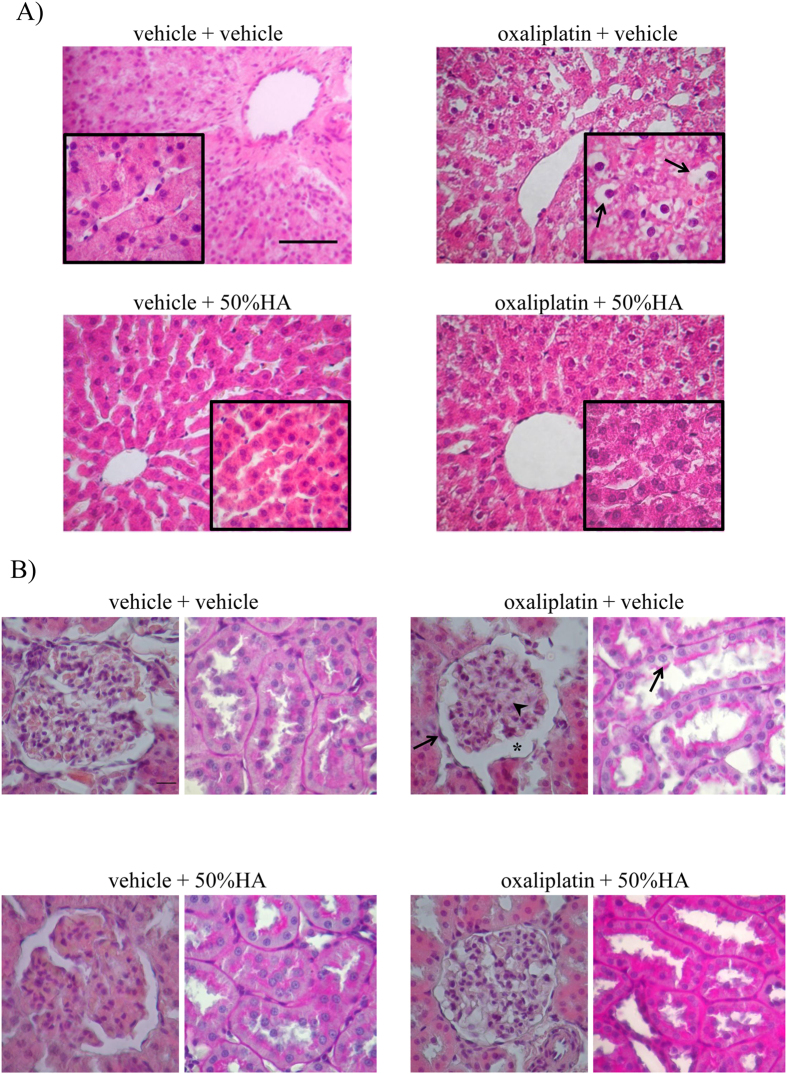
Histological evaluation of liver and kidney.(A) Effect of 50%HA on counteracting histopathological damages induced by oxaliplatin in the liver of rats. In the control animals (vehicle + vehicle), no liver damage was observed. Following oxaliplatin treatment (oxaliplatin + vehicle), fatty change (insert in oxaliplatin + vehicle, black arrows) and inflammatory cell with granular swelling were observed. The liver sections from oxaliplatin + 50%HA show little balloon changes in liver acinus, whereas 50%HA treated animals (vehicle + 50%HA) show no differences with control rats. Scale bar = 10 μm and original magnifications 20X for all the panels. (B) Effect of 50%HA on counteracting histopathological damages induced by oxaliplatin in the kidney of rats. The control animals (vehicle + vehicle) show any signs of kidney damage. Following oxaliplatin treatment (oxaliplatin + vehicle), kidney sections show glomerulopathy with Bowman’s space expansion (left panel, black asterisk), Bowman’s capsule thickening (left panel, black arrow), and mesangial expansion (left panel, black arrowhead), and tubule epithelium swelling and distension, together with severe vacuolar degeneration (right panel, black arrow). Oxaliplatin + 50%HA kidney section shows no pathological changes, as well as the kidney section from 50%HA-treated animals (vehicle + 50%HA). Scale bar = 10 μm and original magnifications 40X for all panels. All pathological observations were performed and graded by experienced and independent pathologists on 6 rats per group (two different experimental sets).